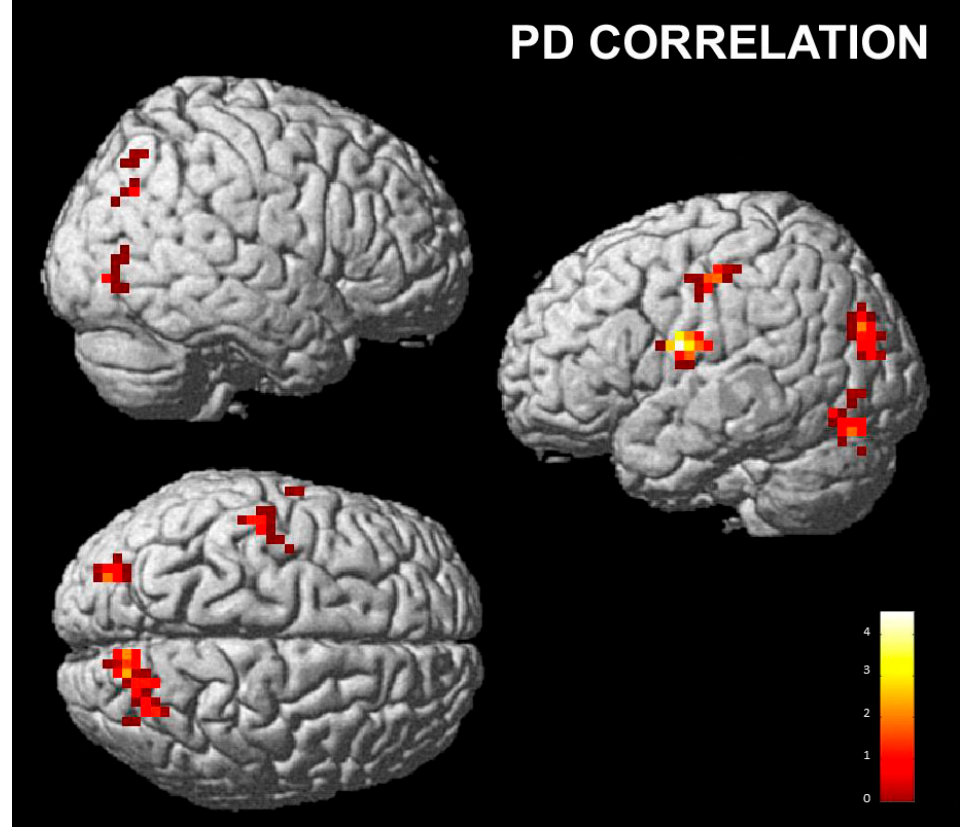
Figure 7. PD correlation with the contrast “posing neutral and perceiving happiness” vs. “posing neutral and perceiving disgust”; cluster size threshold k > 27, corrected at α < 0.05. Same overlay procedure as in Figure